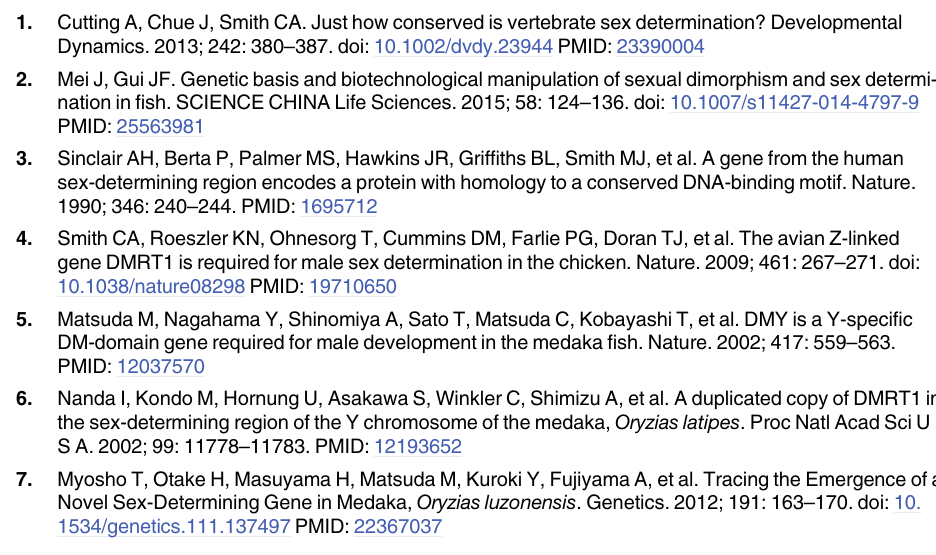
S1 Fig. Length distribution of the de novo assembled unignes. S1 Table. The annotation of unigenes in the transcriptomes. S2 Table. The GO annotation of differently expressed